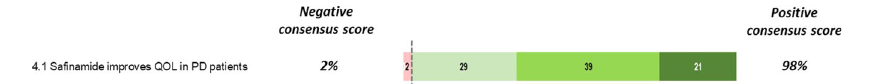
Fig. 4 Delphi questionnaire results: topic 4 “ Quality of life ” . Numbers in the colored bars are the total number of votes received for each level of disagreement/agreement (1, extremely disagree; 2, disagree; 3, agree; 4, mostly agree; and 5, extremely agree). The “ negative consensus score ” and the “ positive consensus score3 are percentage.